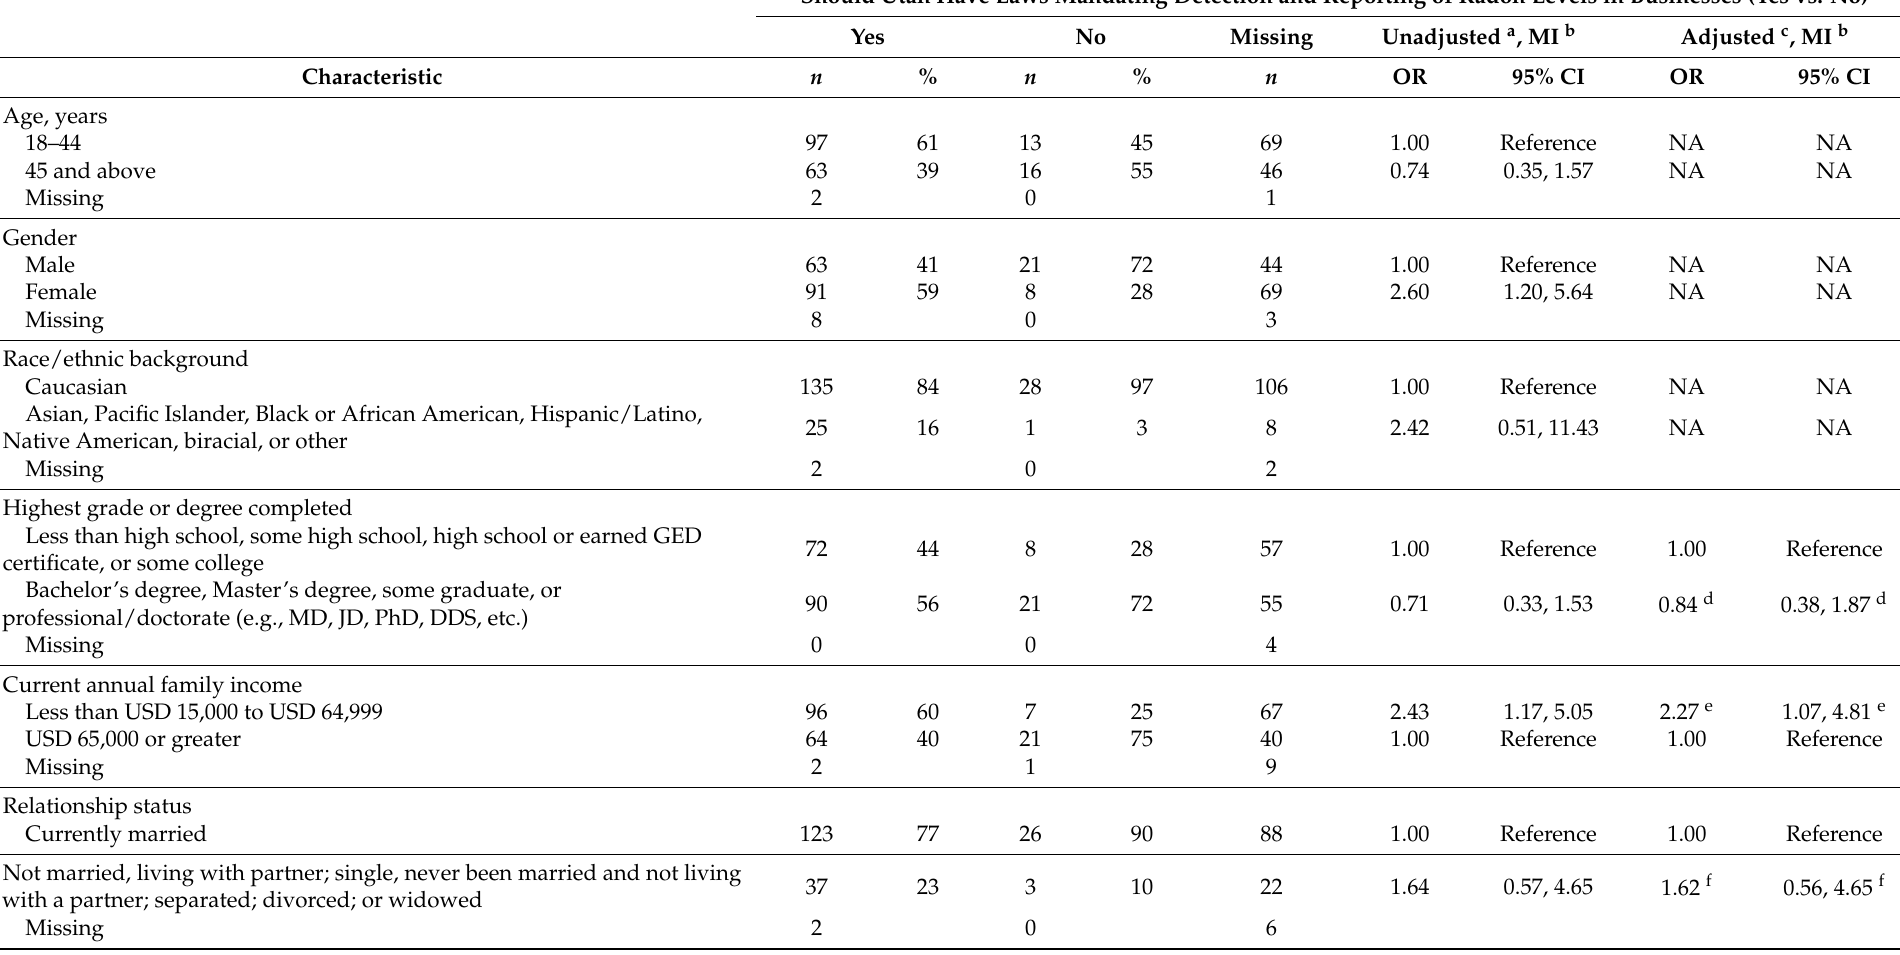
Table 4. Unadjusted and adjusted, multiply imputed associations between characteristics and opinions regarding whether Utah should have laws mandating detection and reporting of radon levels in businesses among radon testing survey participants, Utah County, Utah, May 2014–January 2016. Should Utah Have Laws Mandating Detection and Reporting of Radon Levels in Businesses (Yes vs.